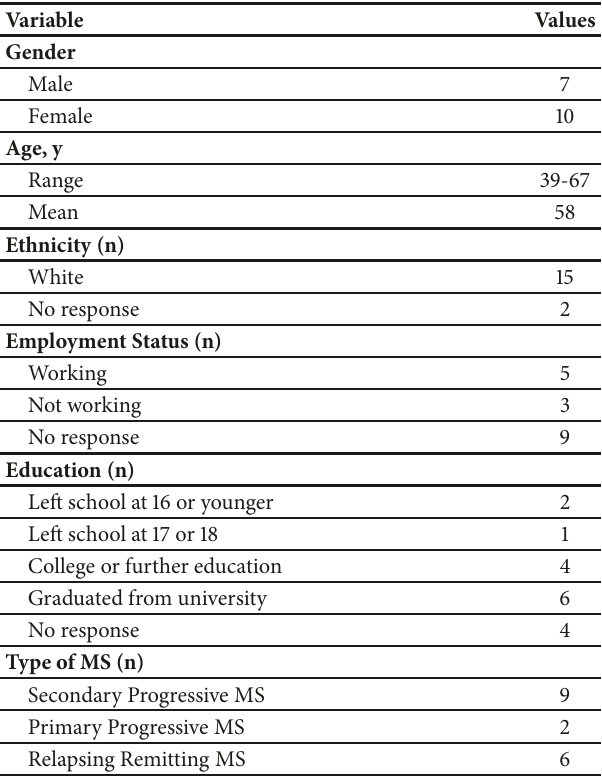
Table 1: Demographic details for qualitative study